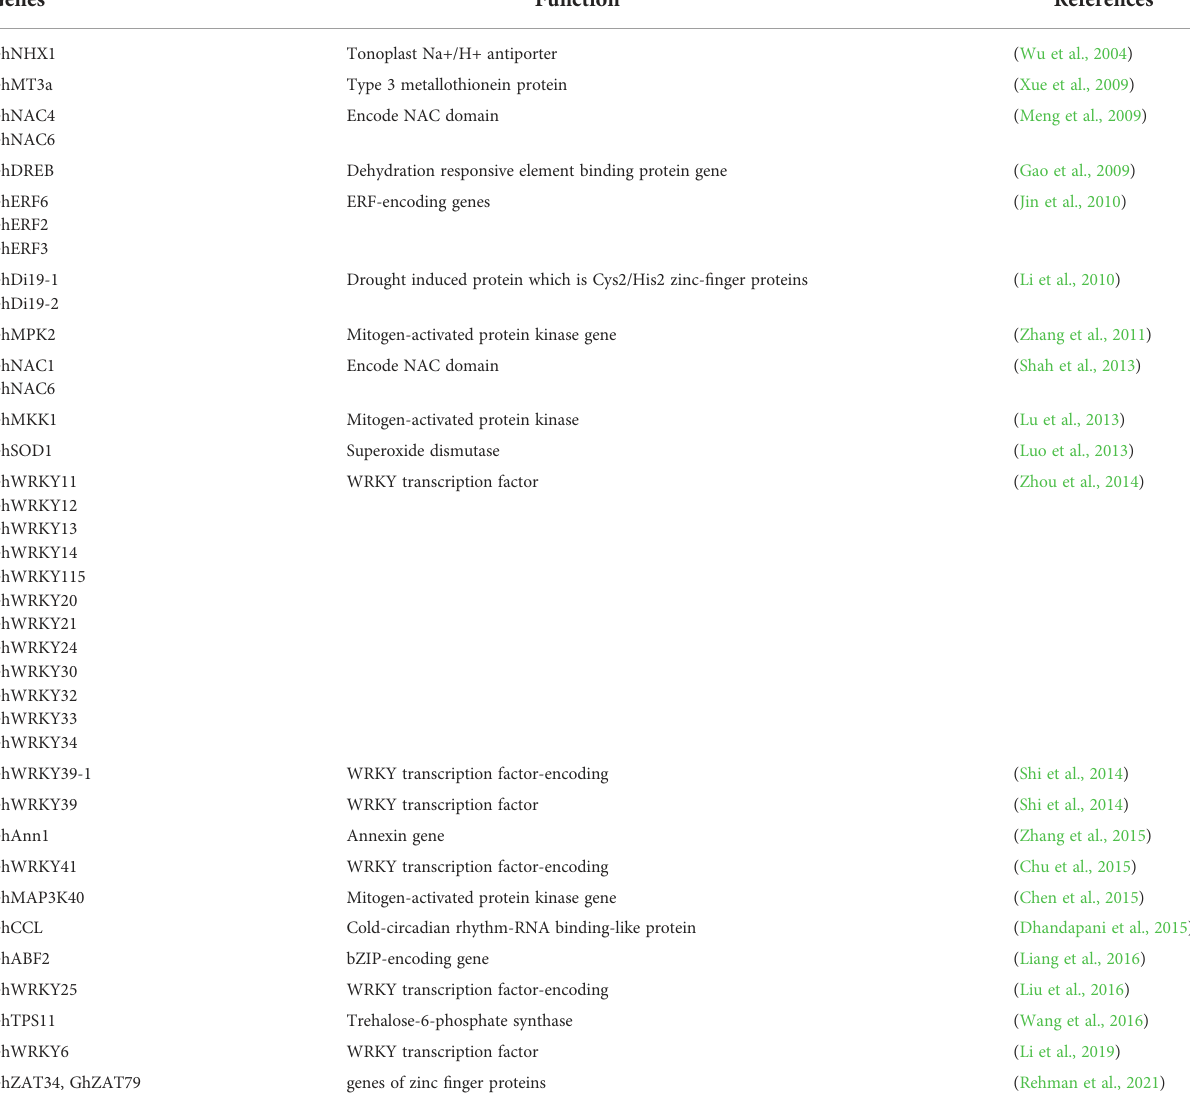
TABLE 1 Functional genomics of salt responsive genes in Gossypium hirsutum L. Genes